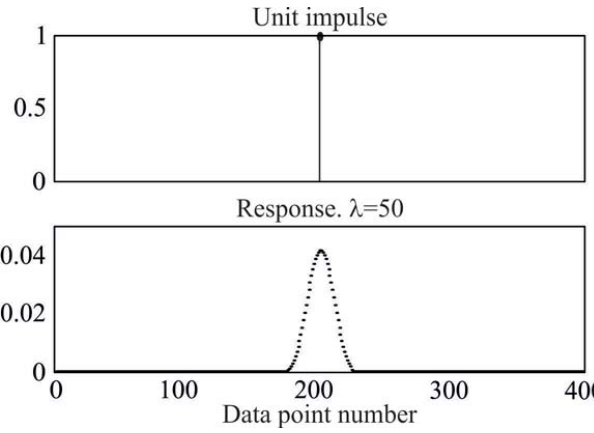
Fig. 2. A unit pulse located at data point number 200 and the cor- responding filter response with a low pass cut off equal to 50 times the uniform interval size on the horizontal axis between neighboring data